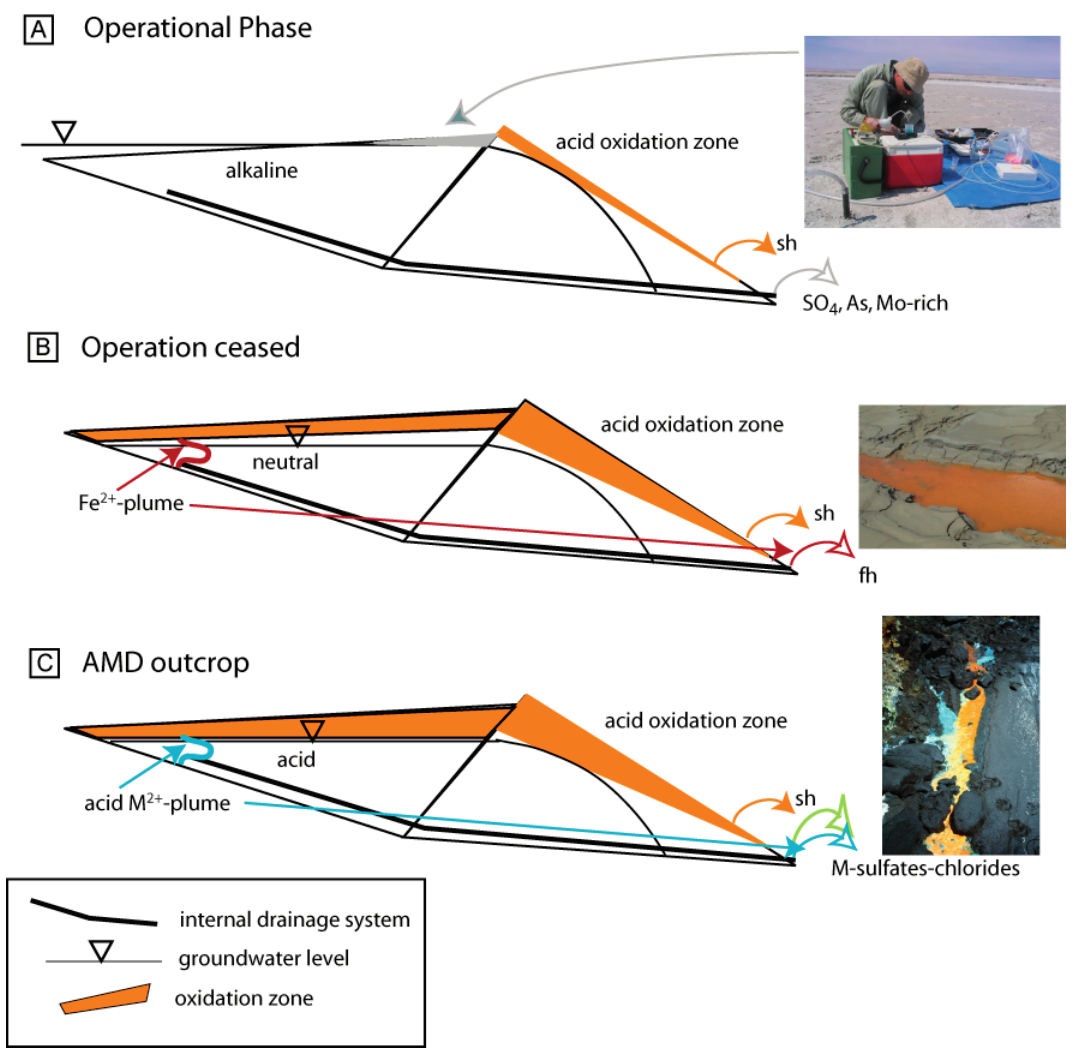
Figure 6. The here shown tailings impoundment is a modern design, with integrated basement impermeabilization and internal drainage system. Most of the tailings impoundments around the world do not have impermeabilization and the contaminated solution will directly infiltrate into the groundwater. ( A ) During the operational phase the system is saturated and alkaline. There might be increased concentrations of oxyanions depending on the mineralogy of the ore. If the dam is built with the coarse fraction of the tailings, oxidation and acidification might start during the operational phase with first signs of AMD (Sh). Surface precipitates are white at this stage. ( B ) After operation has ceased, an acid oxidation zone will develop and a ferrous iron plume below the oxidation front can migrate at neutral pH conditions in the tailings stratigraphy. This neutral, ferrous iron-rich plume will produce ferrihydrite (Fh) at its outflow. And ( C ) acid production due to sulphide oxidation continues and the neutralization potential will be completely consumed, resulting in an acid flow in the tailings mobilizing heavy metal cations and resulting in the formation of AMD with multi-colour precipitates (mainly metal sulphates and/or